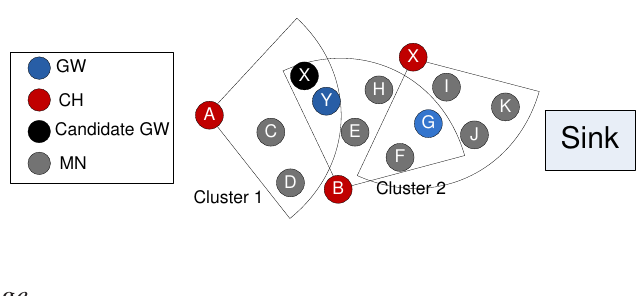
Figure 3. Gateway node